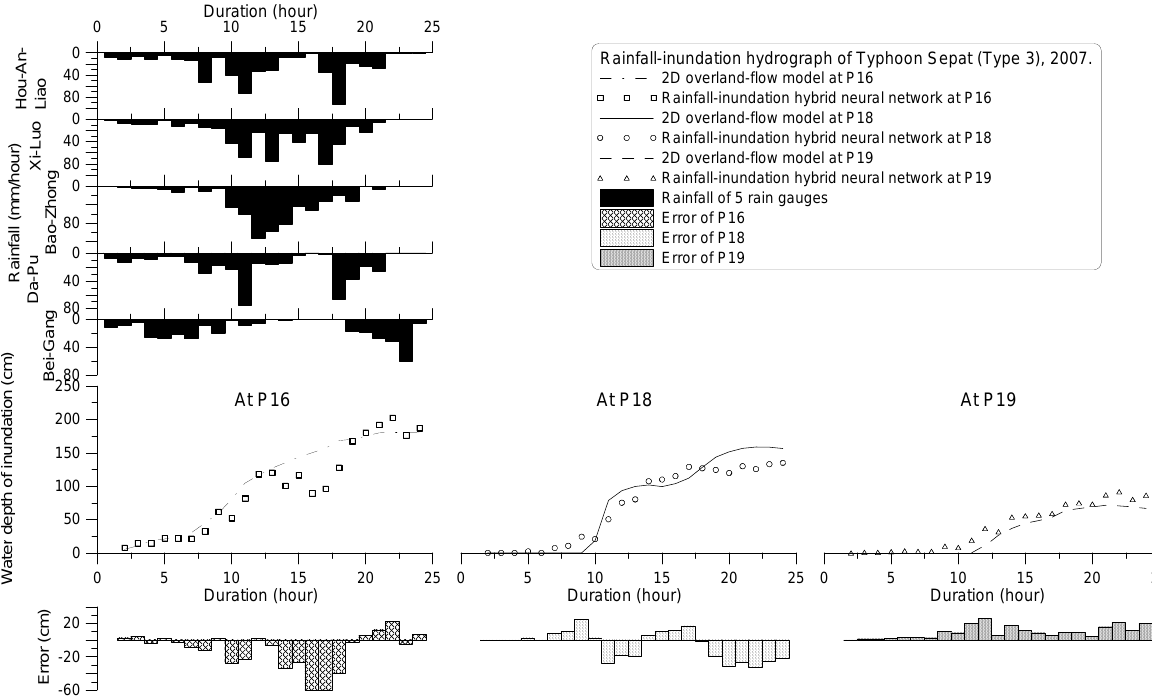
Fig. 11. The rainfall-inundation hydrograph of Typhoon Sepat (Type 3) in 2007.